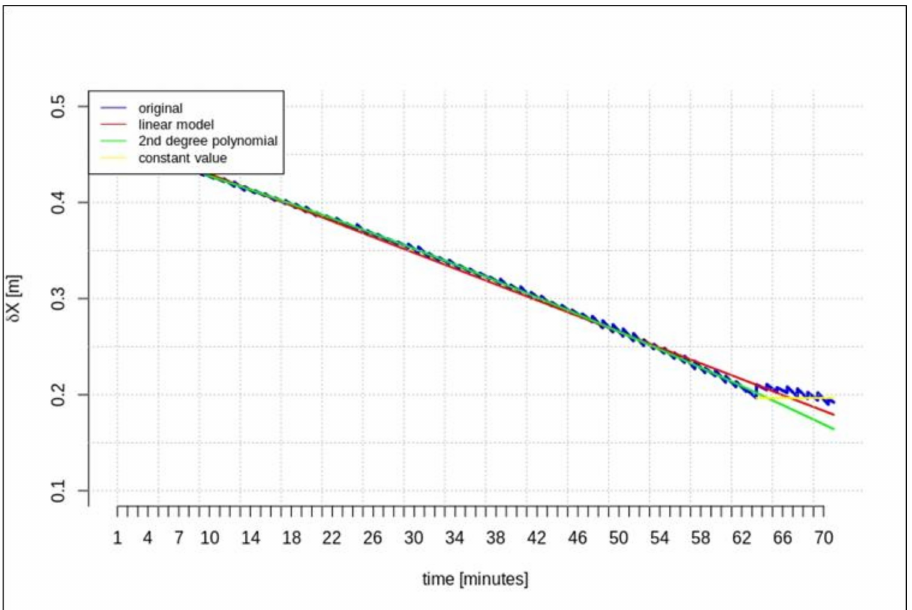
Figure 5. The results of the δ X geocentric correction extrapolation (GPS G13) for a 70 min data-stream—the time series of orbit corrections refer to an out-of-date navigation message.